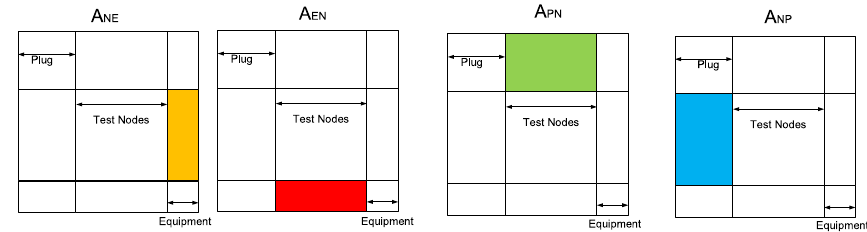
Fig. 4 Adjacency matrices of AWET heterogeneous